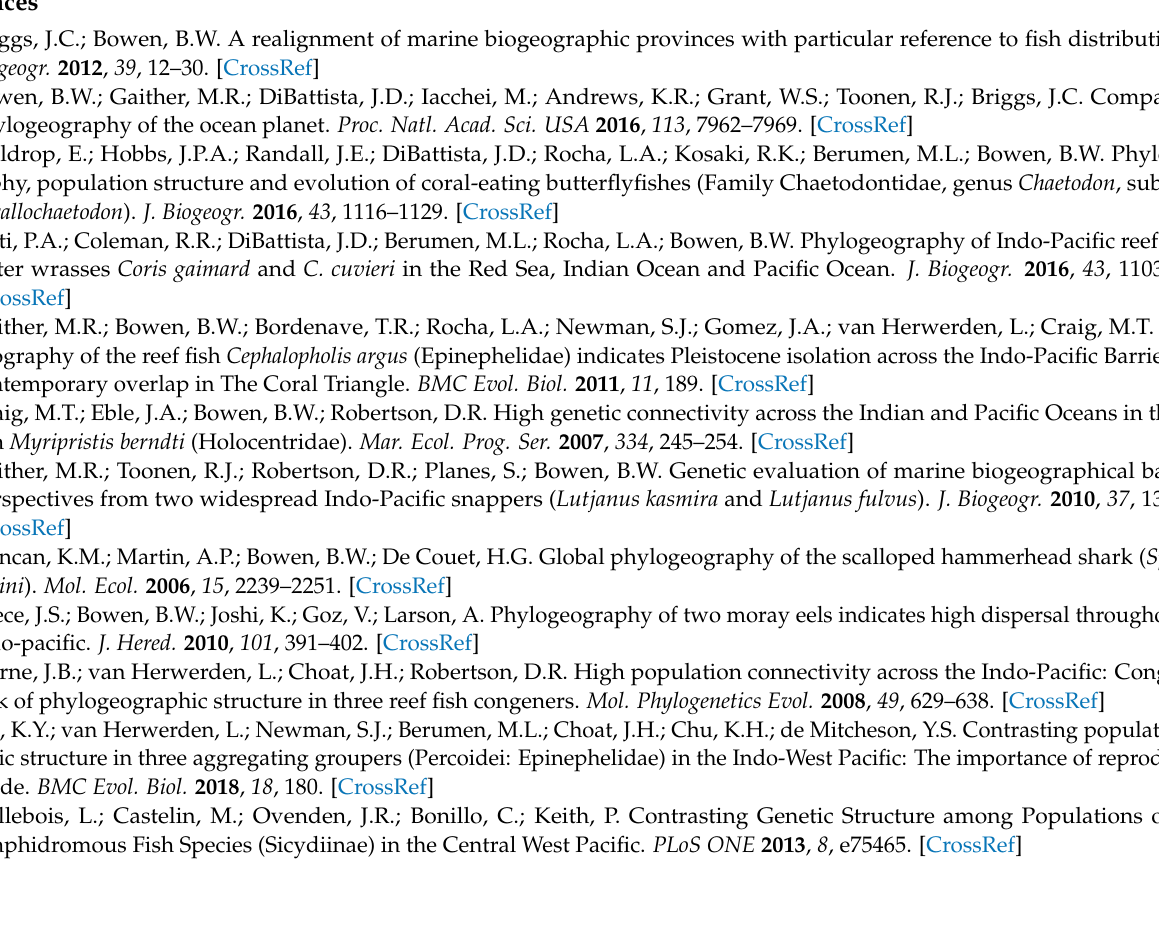
for each cluster, Figure S3: Coalescent-based species tree, Figure S4: Likelihood distributions for different models, Table S1: Numbers of enriched genes for each individual, Table S2: Values of Tajima’s D test and Fu’s Fs